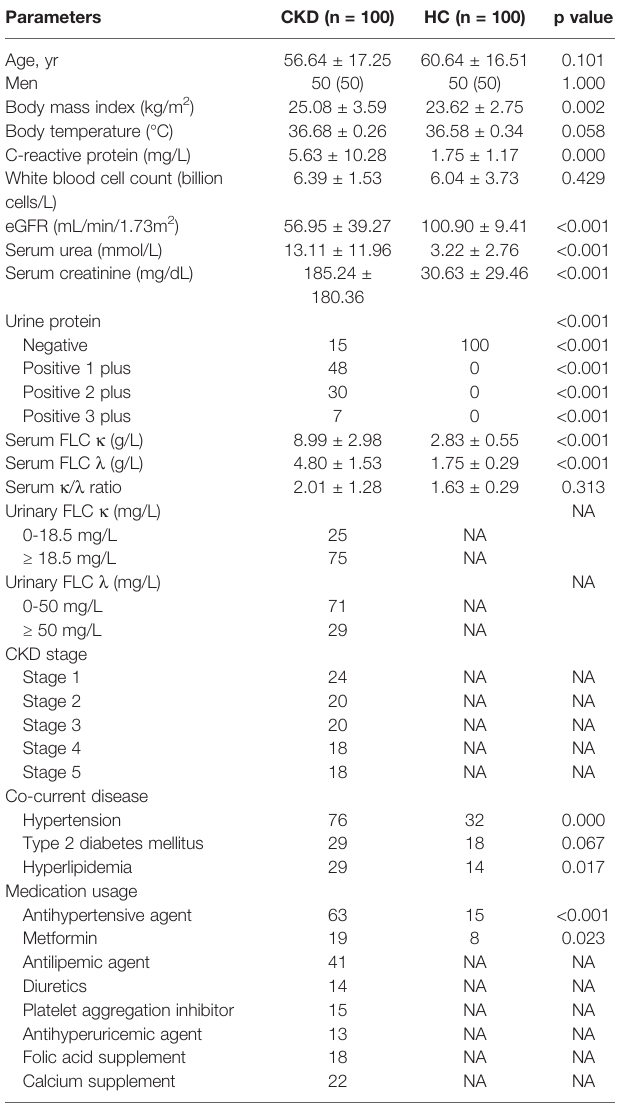
TABLE 1 | Characteristics of the